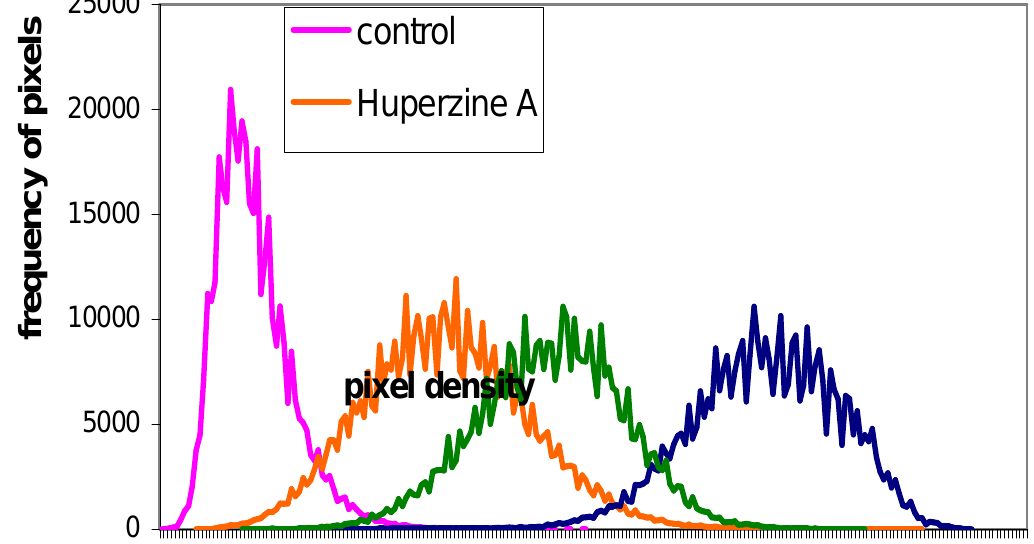
Bottom: Quantitative evaluation of histochemical data: Density curves of microphotographs.